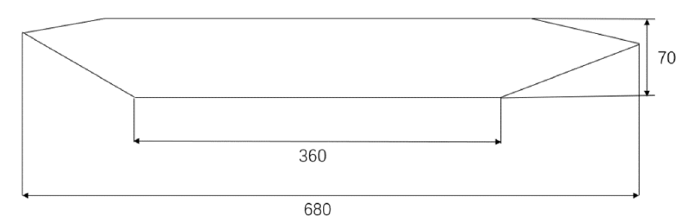
Figure 6. Schematic diagram of grid model of main beam section (mm).